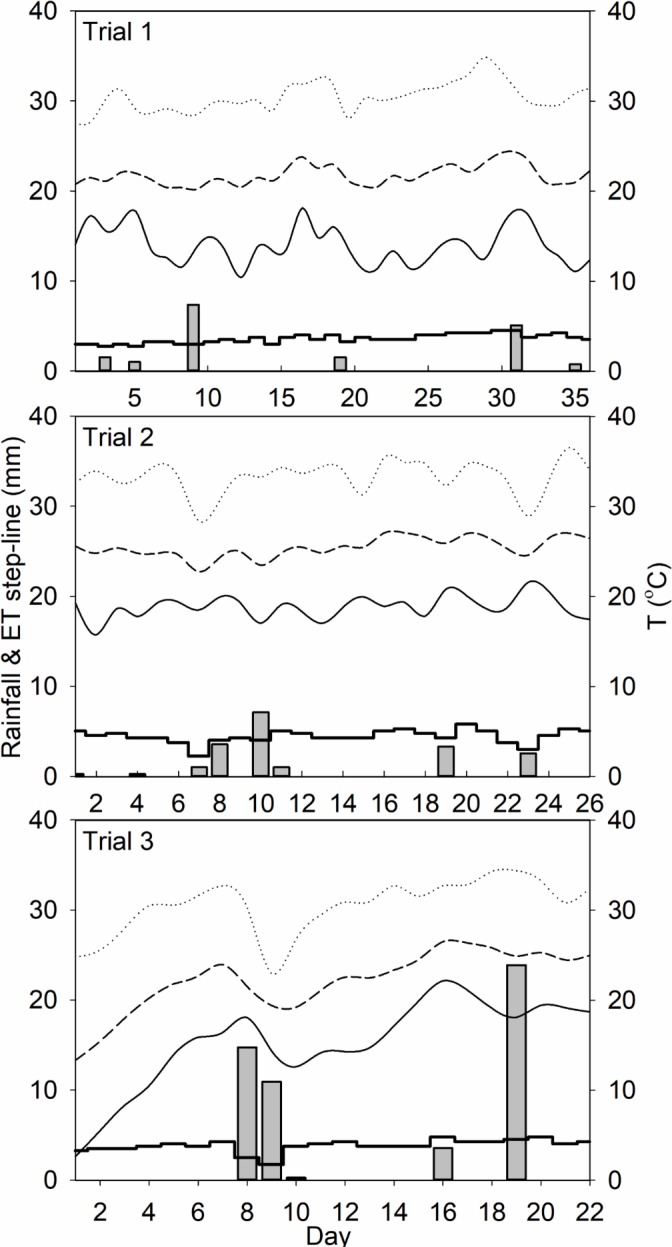
Rainfall (bars), evapotranspiration or ET (step-line), and temperature data (⋯ maximum, ₋ ₋ ₋ average, ― minimum) during trial 1 (Day 1: March 7th, 2012), trial 2 (Day 1: May 10th, 2012), and trial 3 (Day 1: March 28th, 2013).